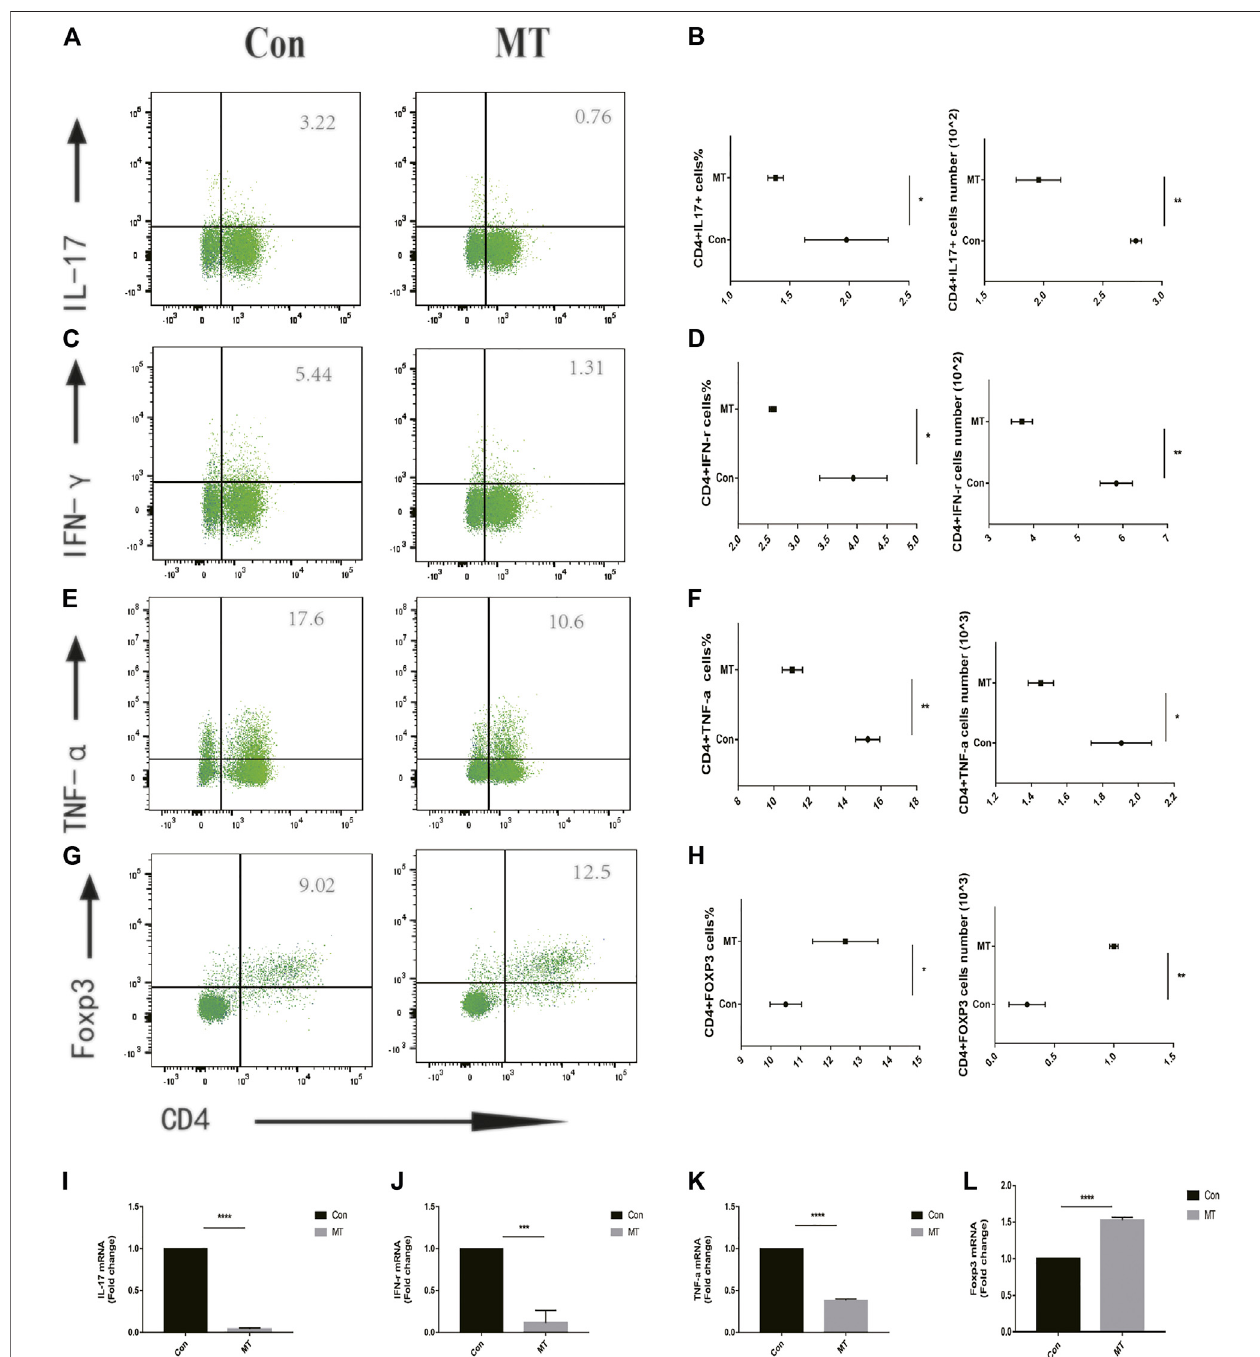
FIGURE4| MTregulatesTeff/Tregbalanceincornealgraftmodelmice. (A – F) Onthe9thdayafteroperation,thelevelsofTeff/TregcellsinDLNsweremeasuredby fl owcytometry.MTwasfoundtoinhibittheproportion ofTh1/Th17cellsinDLNs( n (cid:1) 6pergroup). (G – H) ,whiletreatmentincreasedtheproportion ofTregcellsinDLNs ( n (cid:1) 6pergroup). (I – L) Real-timequantitativePCRwasusedtomeasuretheexpressionlevelofin fl ammatoryrelatedmRNA.MTinhibitedthemRNAexpressionofIL-17, IFN- γ , TNF- α , and Foxp3 ( n (cid:1) 4 per group). (Con: control group; MT: treated with MT). * p < 0.05, ** p < 0.01, *** p < 0.001.